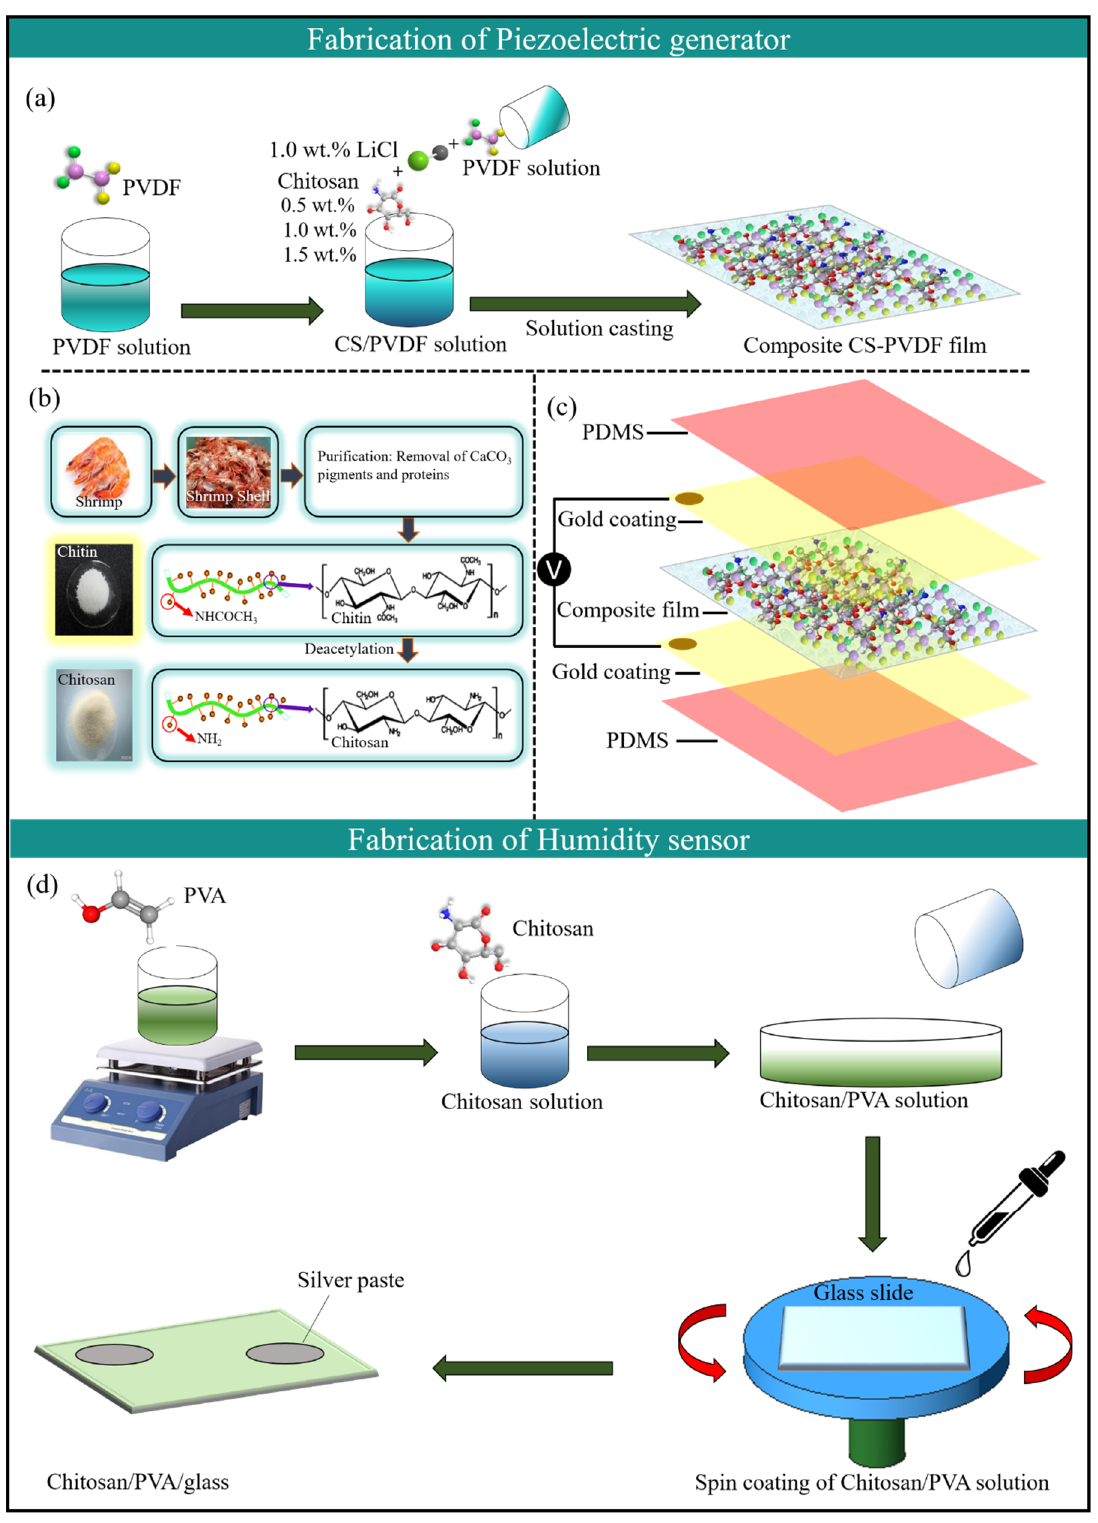
Figure 1. ( a ) Schematic illustration of the fabrication process for the CS ‐ PVDF ‐ based PNG film, ( b ) schematic illustration of the conventional process for chitosan preparation from shrimp shells, ( c ) schematic diagram of the developed piezoelectric nanogenerator, ( d ) schematic illustration of the fabrication process for the CS ‐ PVA ‐ based humidity sensing film.